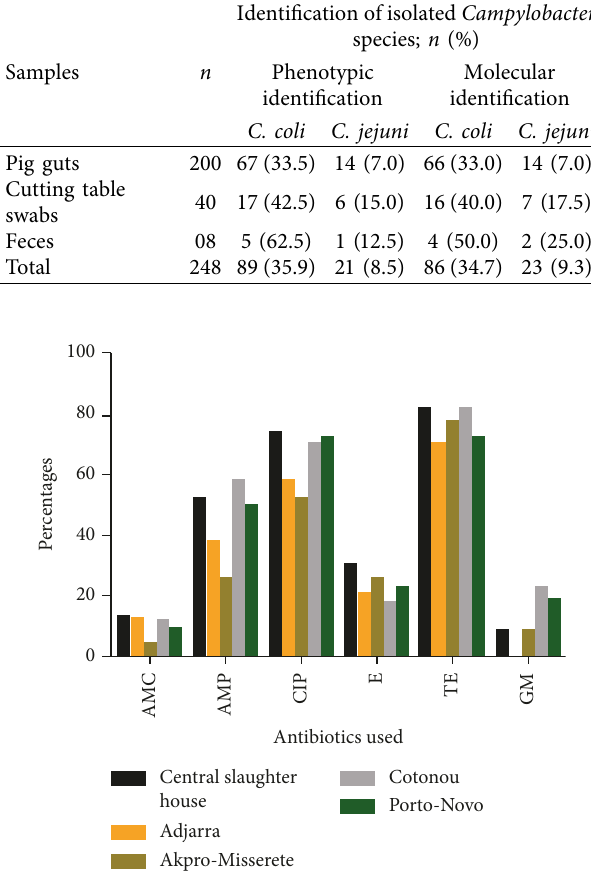
Figure 2: Distribution of the resistance of Campylobacter strains identified according to the sampling locations. AMC: amox- icillin+clavulanic acid; AMP: ampicillin; CIP: ciprofloxacin; E: erythromycin; TE: tetracycline; GM: